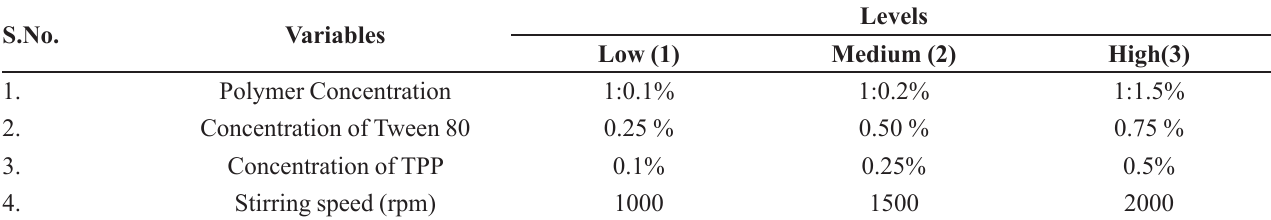
(3 4 ) orthogonal array for chitosan 9